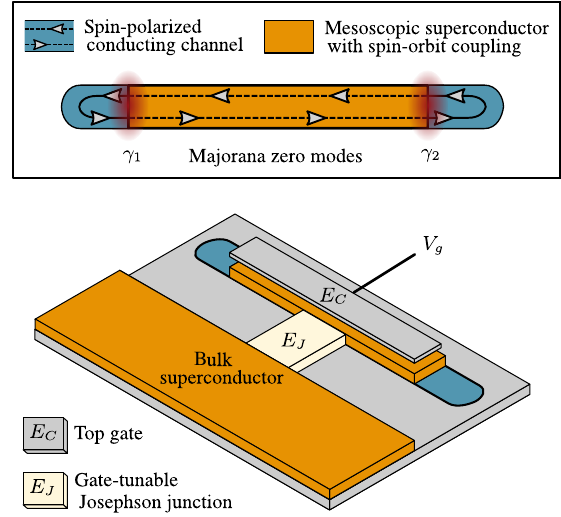
FIG. 14. A Majorana Cooper pair box as a basic building block of the topological hardware. Top diagram: A pair of Majorana zero modes γ 1 and γ 2 at the ends of a p -wave superconductor can be effectively obtained by depositing an s -wave superconductor with strong spin-orbit coupling on top of a material with a single spin-polarized conducting channel, such as a semiconducting nanowire in a magnetic field, a quantum anomalous Hall insulator, or a 2DEG in a strong magnetic field. Bottom diagram: A Majorana Cooper box requires the addition of charging energy E and Josephson energy E on the mesoscopic superconducting C J island. A top gate that is capacitively coupled to the super- conducting island imposes a certain total charge on the island governed by the gate voltage V and the (fixed) charging energy. g Furthermore, a bulk superconductor is Josephson coupled to the mesoscopic island through a gate-tunable Josephson junction, which tunes the Josephson energy and imposes a certain phase on the